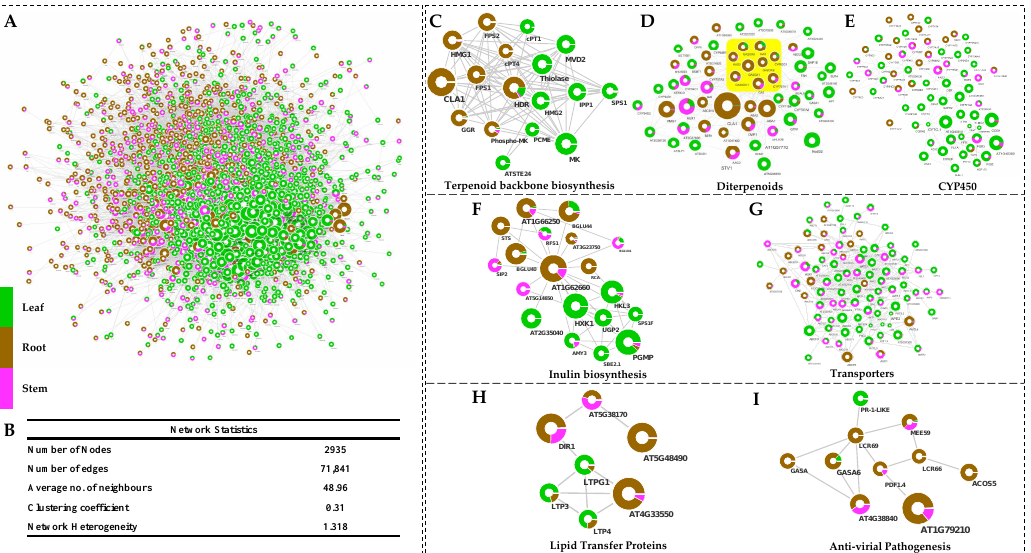
Figure 5 Figure 5. ( A ) Predicted interrologous transcriptional interactome network, ( B ) table representing network statistics, ( C – E ) significantly enriched unigenes corresponding to ( C ) terpenoids, ( D ) diter- penoids, and ( E ) the CYP450 family. Predicted significant interactions of unigenes involved in starch and sucrose metabolism regulating ( F ) inulin biosynthesis and ( G ) transporters. Enriched interaction Int. J. Mol. Sci. 2022 , 23 , x FOR PEER REVIEW representing unigenes involved in ( H ) lipid transfer proteins and ( I ) antiviral pathogenesis.